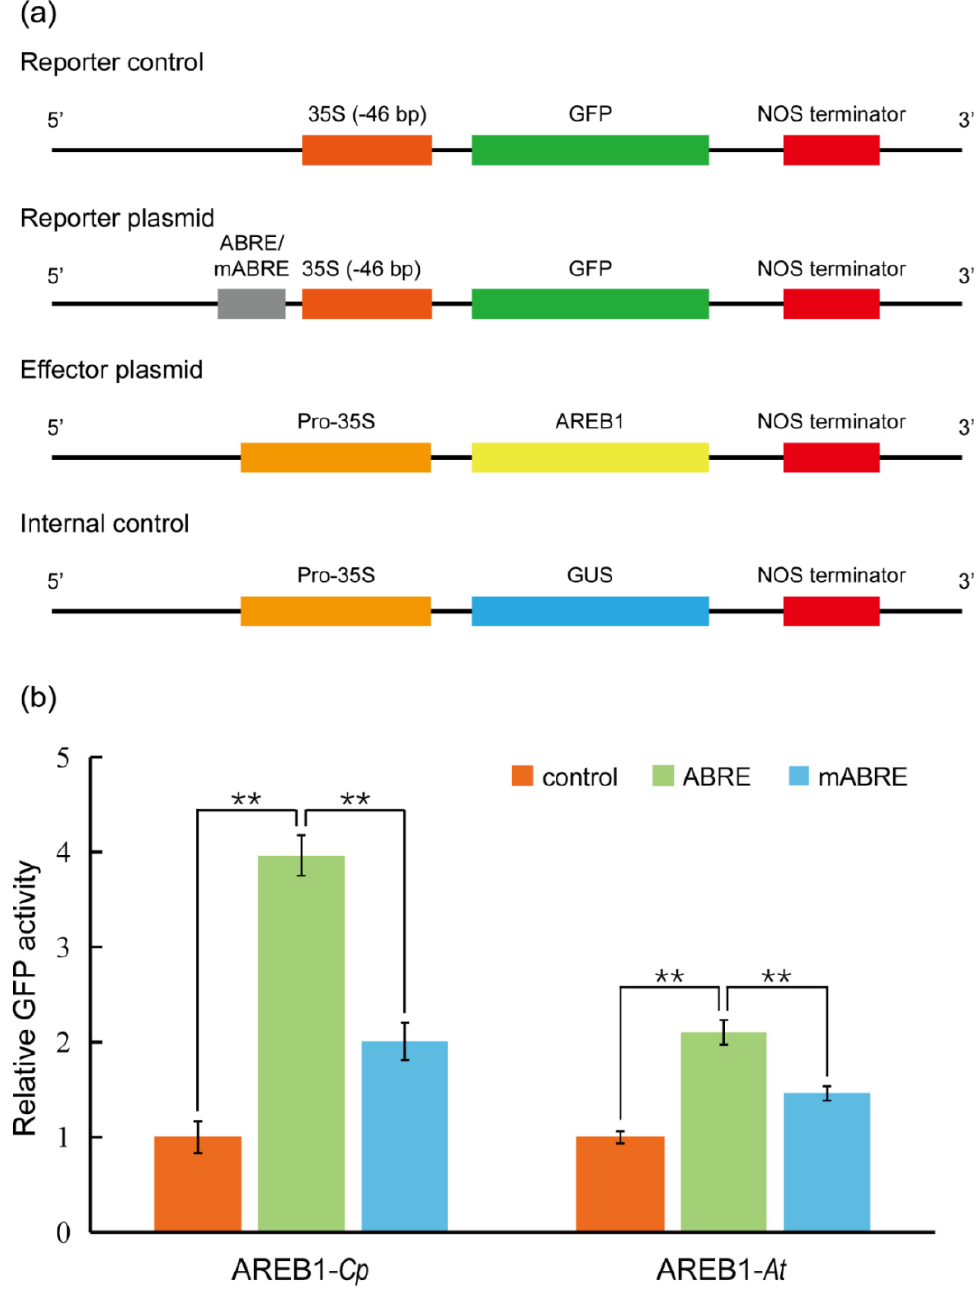
Figure 5. Transient gene expression analysis using C. pumila mesophyll protoplasts. ( a ) Schematic diagrams of plasmids used in the transient transactivation assays. The GFP driven by CaMV35S minimal promoter 35S ( − 46 bp) was used as a control. Four tandem repeats of ABRE or mutated ABRE(mABRE) fused with CaMV35S minimal promoter were used as reporter plasmids. AREB1 and GUS driven by CaMV35S promoter were used as effector plasmid and internal control, respectively. ( b ) AREB1 could activate the expression of the GFP reporter and the activation effect was significantly abolished when the core ABRE was mutated. Similar results were observed from the assays in Arabidopsis leaf protoplasts. The relative expression level of GFP was normalized to the internal control of GUS expression. The values shown are the average of three biological replicates. The statistical significance test was performed with Student’s t test (**, p value <